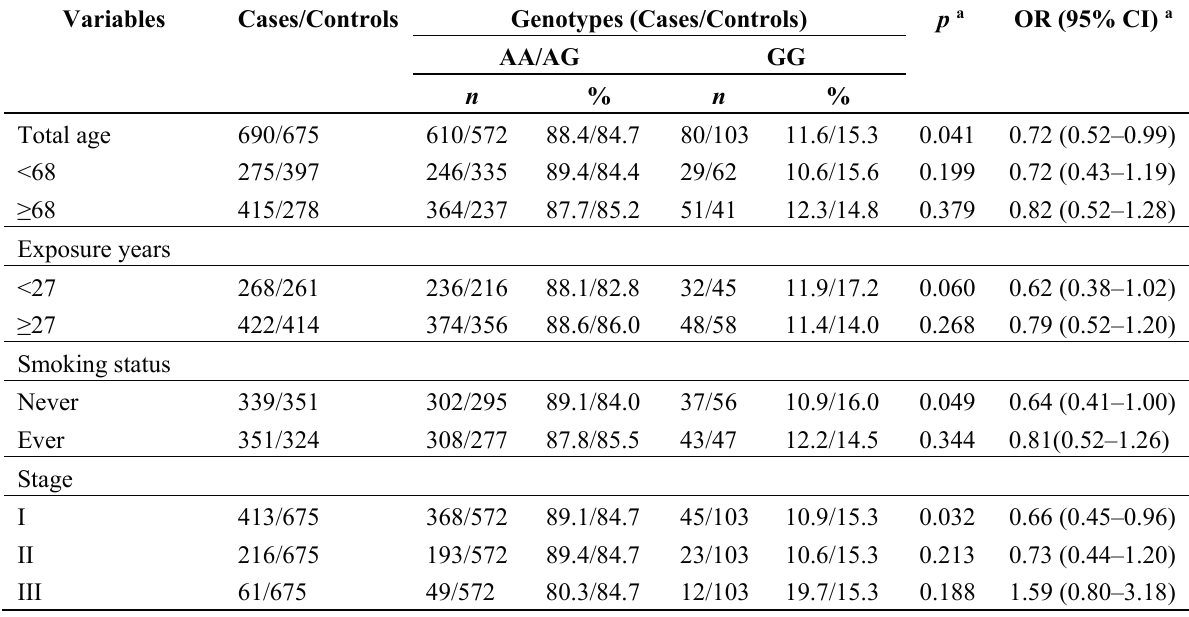
Table 4. Stratification analyses between the genotypes of MMP3 rs522616 and CWP risk. Variables